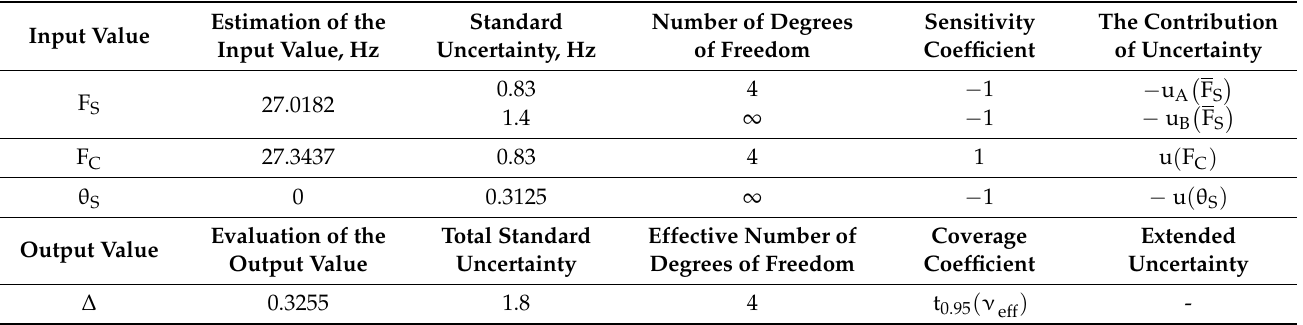
Table 1. Measurement uncertainty and comparison of diagnostic results of an etalon bearing and experimental bearing with damaged inner